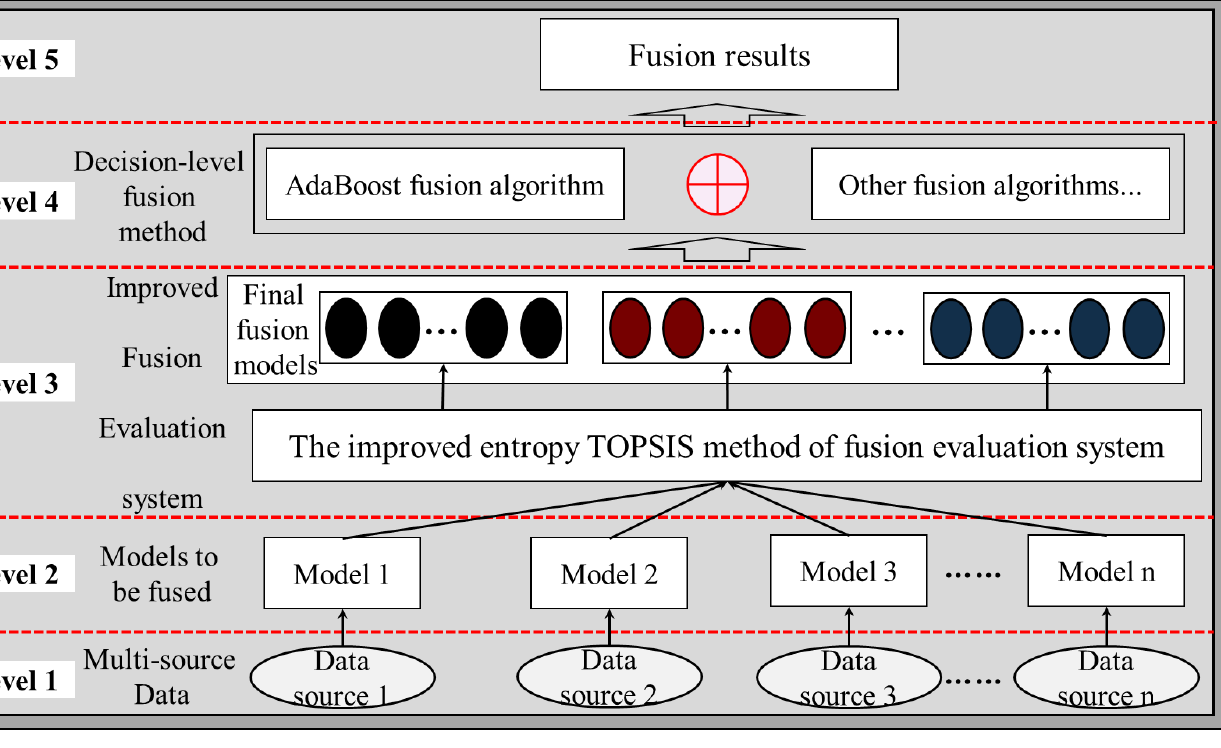
Figure 8. Multi-source data fusion evaluation system and fusion